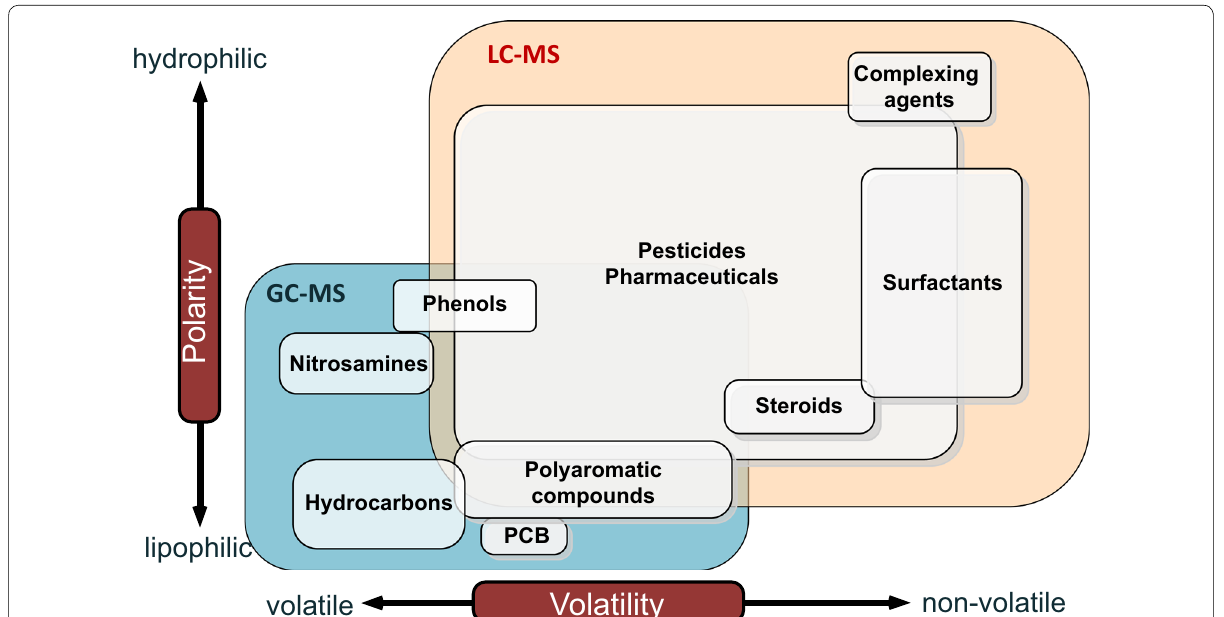
Fig. 1 Domains of GC–MS and LC–MS techniques for emerging contaminants in terms of hydrophobicity and volatility. Atmospheric pressure techniques result in increasing overlap for both LC and GC–MS. The figure follows the concept of Ternes et al.